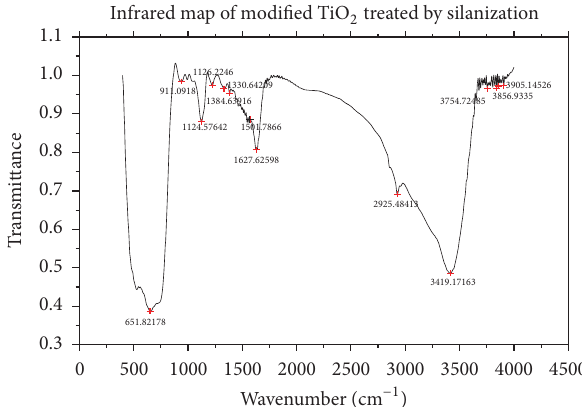
Figure 3: FTIR spectrum of TiO 2 nanotubes treated by silanization.